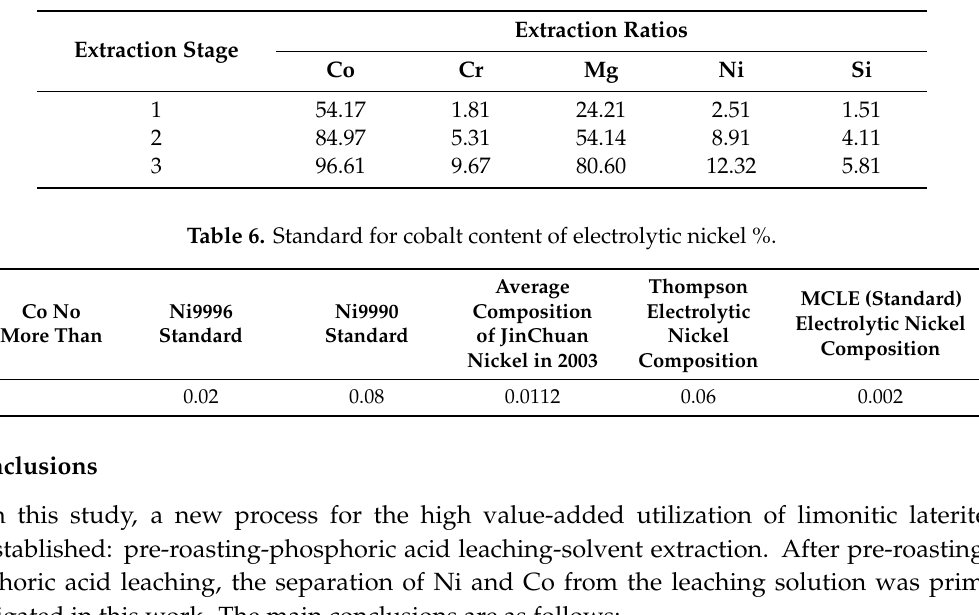
Table 5. Extraction ratios of di ff erent ions %.